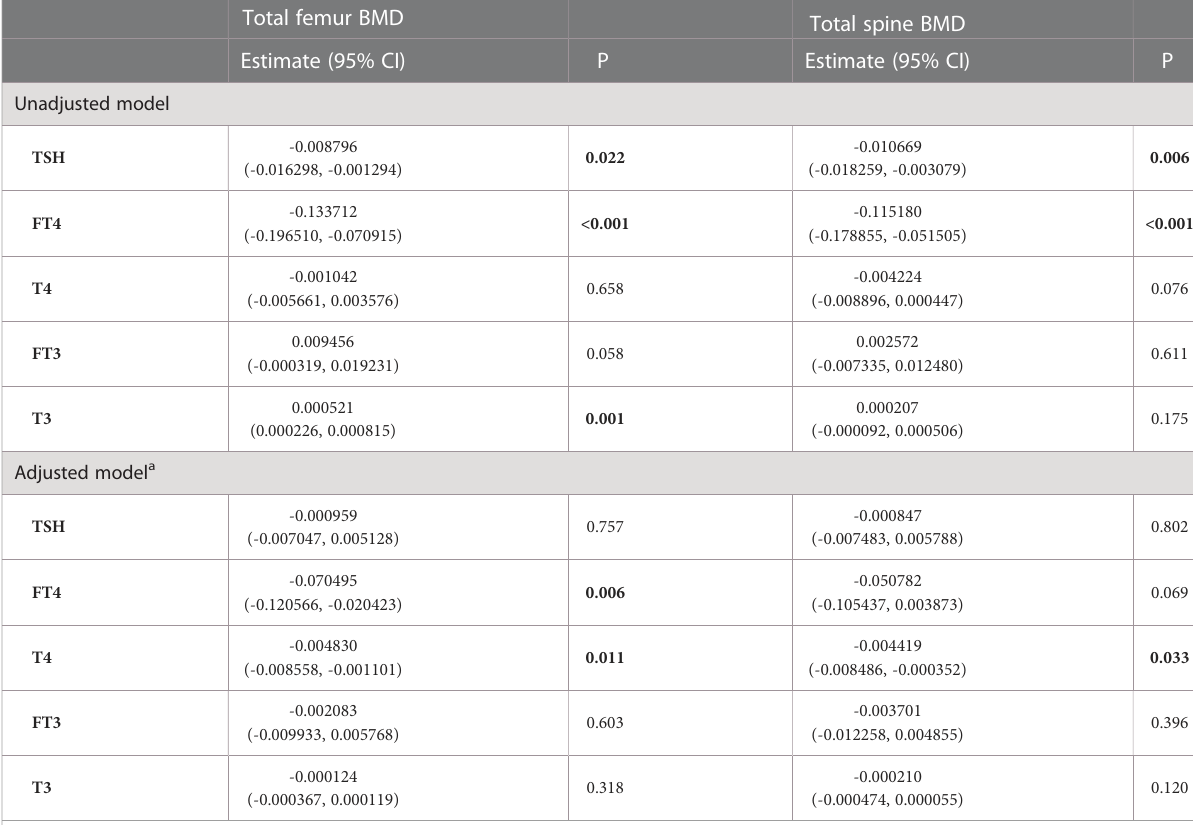
TABLE 4 Association of the thyroid hormone pro fi le with BMD in women.